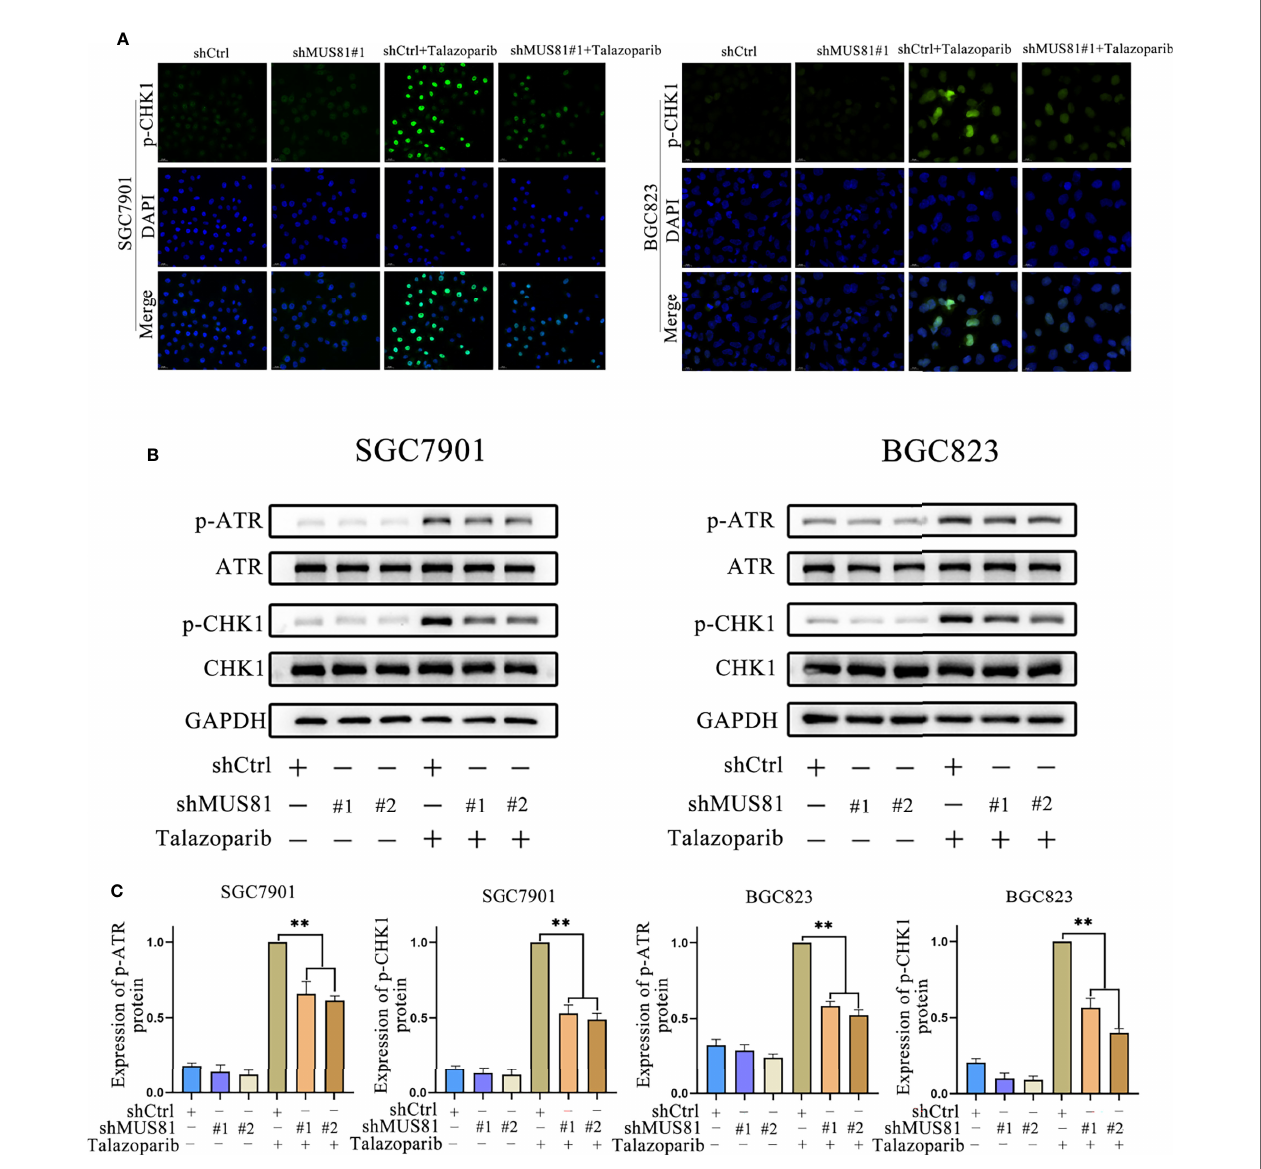
FIGURE 4 | MUS81 de fi ciency impairs ATR/CHK1 activation induced by talazoparib in gastric cancer. (A) Immuno fl uorescence to detect p-CHK1 expression in talazoparib-treated (0.5 µmol/L) cells for 2 d. Magni fi cation, 400×. (B, C) Western blot analysis examining the expression of p-ATR and p-CHK1 after treatment with 0.5 µmol/L talazoparib for 24 h ( t -test). ** P <